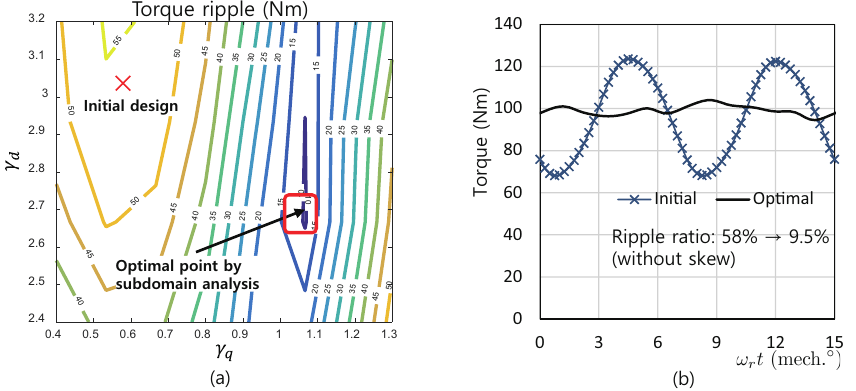
Figure 9. FEA optimization results when β = 44 ◦ with PM magnetized: ( a ) level plot of torque ripple and ( b ) torque versus time.